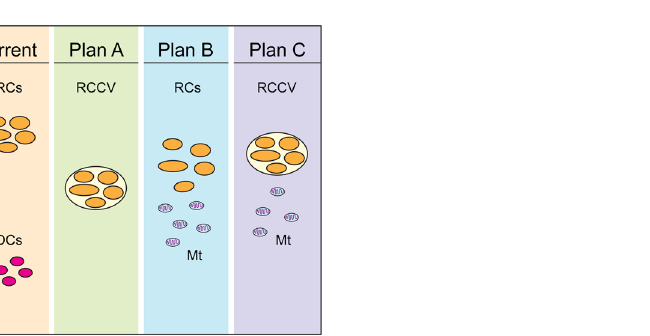
Figure 7. Protein biosynthesis and DNA synthesis assessed simultaneously by measuring the 35 S Cys-Met and 3 H thymidine incorporation, respectively in the axenic media at varying pHs of the media. ( A ) Scintillation counting data for the 35 S Cys-Met assessed with G6P as the energy source. ( B ) As in panel A, except that the scintillation counting data for the 3 H thymidine incorporation was assessed. Significant changes noted relative to CHL control are identified with a * above each bar.